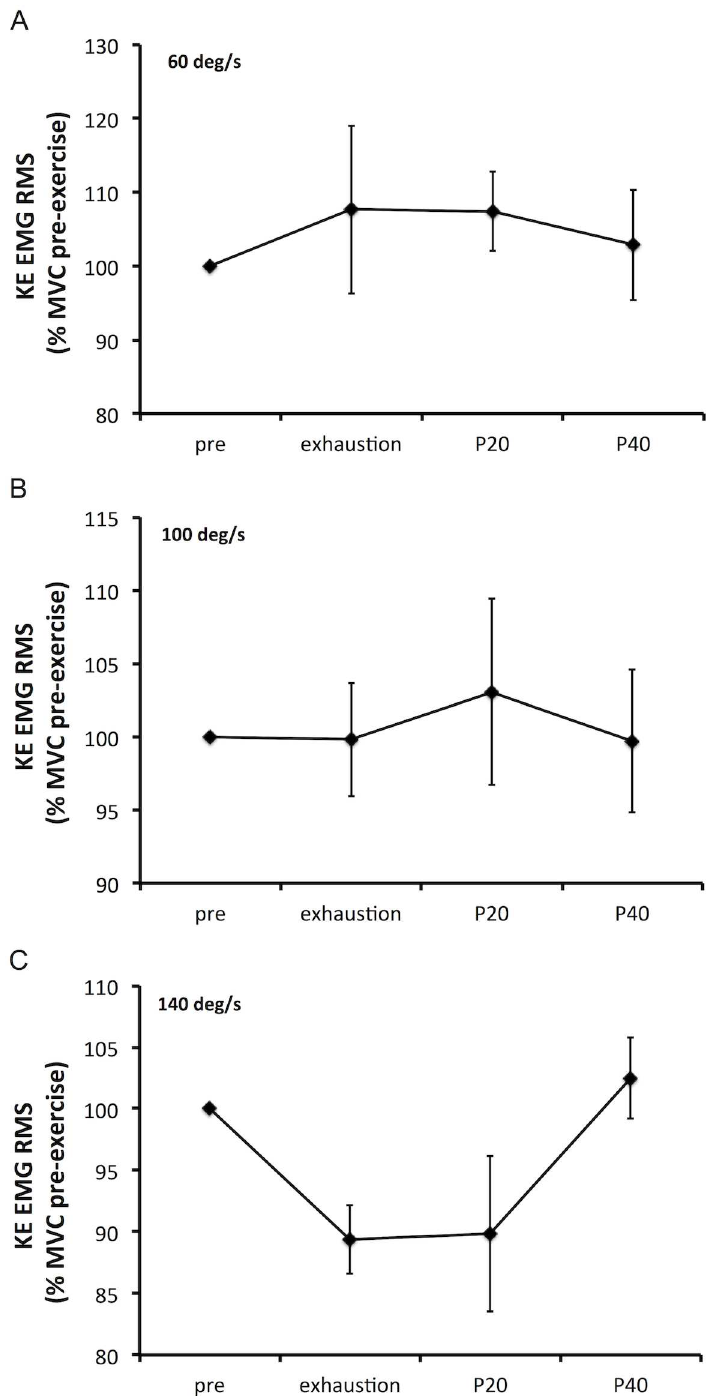
Fig 7. Changes in electromyography root mean square (EMG RMS) during isokinetic knee extensors maximal voluntary contraction (KE MVC) following the time to exhaustion tests (85% peak power output) and during recovery. KE EMG RMS corresponds to the sum of EMG RMS of the following muscles: Vastus Lateralis, Rectus Femoris and Vastus Medialis. Isokinetic KE MVCs were performed at 60 (panel, A), 100 (panel B) and 140 (panel C) deg/s. Isokinetic KE MVCs were measured pre-exercise (pre, averageof all three sessions pre-exercisevalues), shortly after exhaustion (13 ± 4 s after exhaustion), 20 s followingexhaustiontest (P20) and 40 s followingexhaustion test (P40). Data are presented as mean